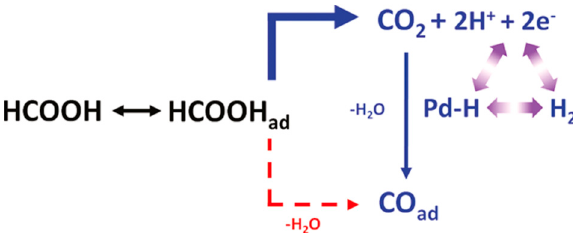
Figure 1. The reaction pathway for the electrooxidation of formic acid over Pd. Reproduced with permission [46]. Copyright 2011, American Chemical Society.